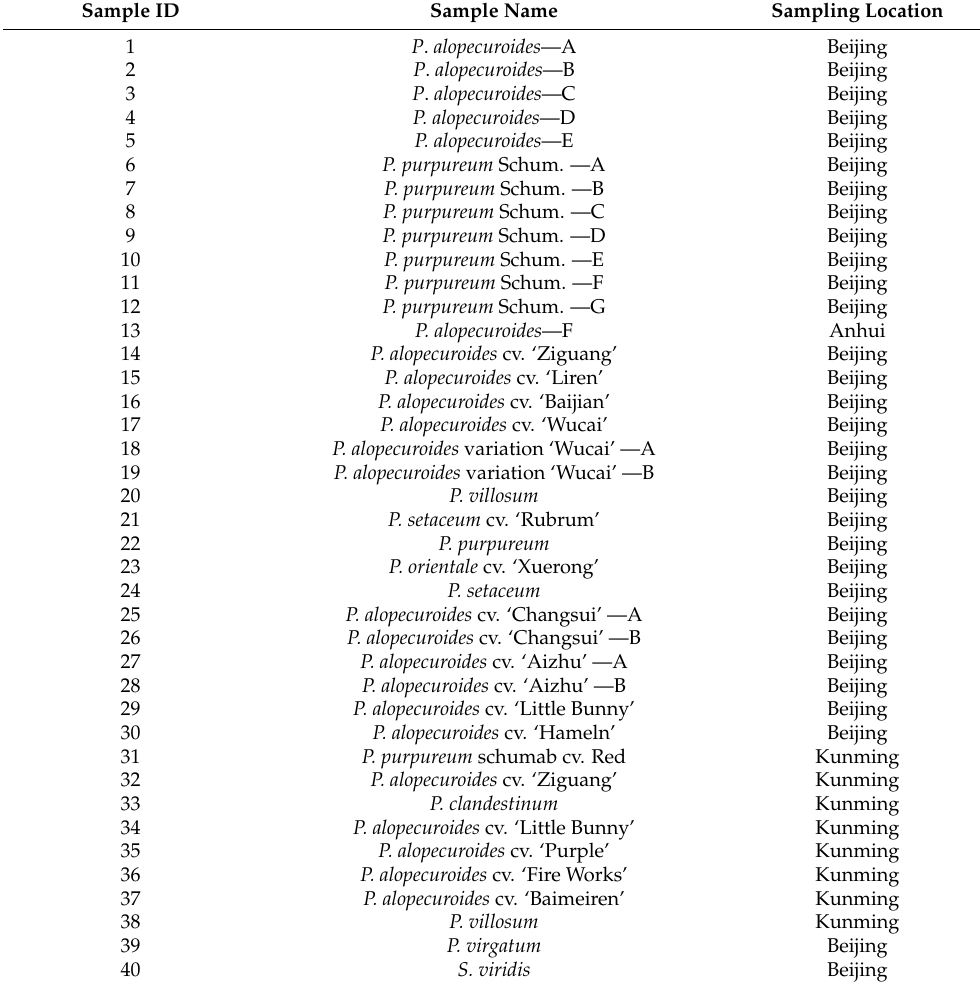
Table 1. The information of 38 Pennisetum and 2 control